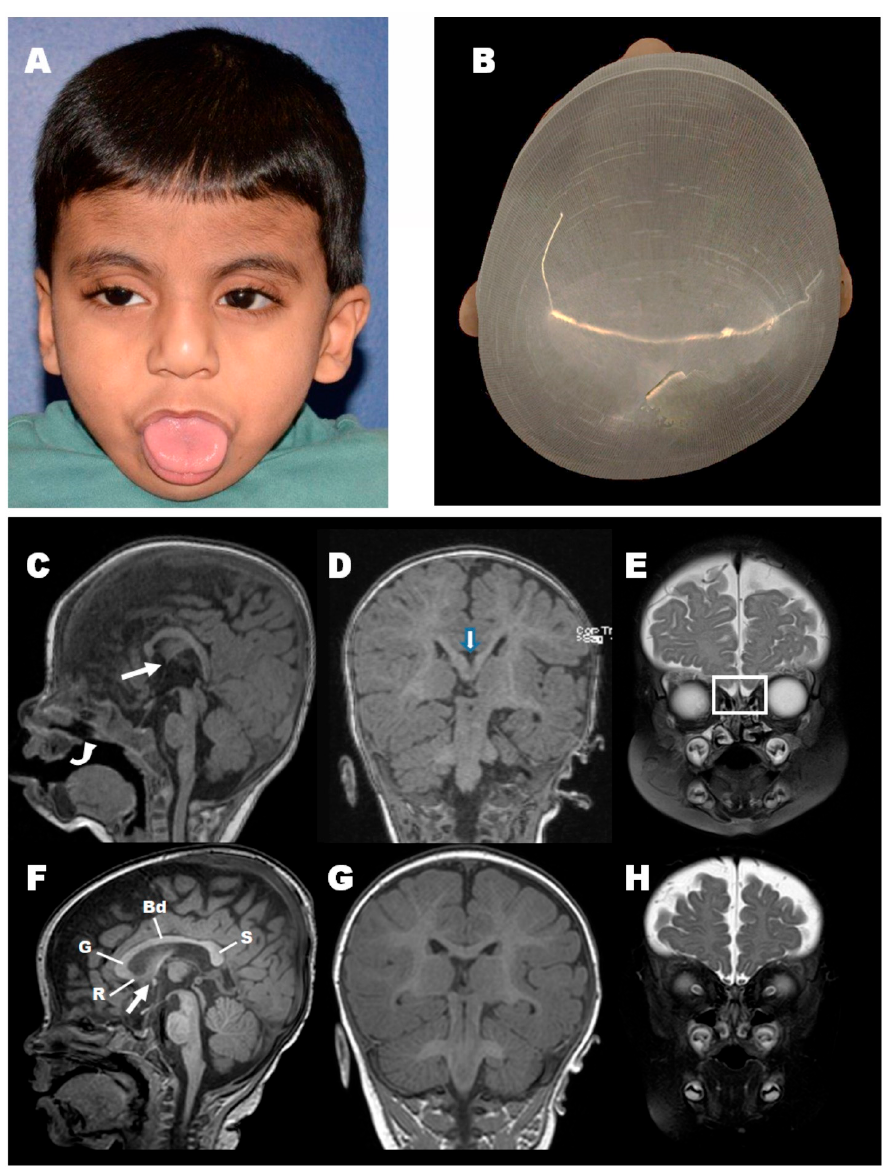
Figure 1. Reported case clinical presentation and Magnetic Resonance Imaging findings. Facial photos of the presented patient at 45 months of age. ( A ) Note the congenital blepharoptosis, tongue thrust posture, mild left ear constriction, mild frontal hirsutism. ( B ) Plagiocephalic head shape. (Note: The key clinical finding of cleft palate is not visible in these images). ( C ) Brain MRI showing midline sagittal T1 weighted image demonstrates a dysplastic corpus callosum with an atypical configuration showing focal thinning at the genu of the corpus callosum and an elongated vertically oriented splenium of the corpus callosum. The anterior commissure is hypoplastic (thin arrow). Cleft Palate is also noted (curved arrow). ( D ) Coronal T1 weighted image shows a cleft at the level of the splenium (thick arrow) denoting partial agenesis. ( E ) Coronal T2 weighted image shows the absence of the olfactory bulbs (Rectangle). ( F – H ) Similar views of an age match control show the normal configuration of the corpus callosum, which is divided into four parts: Rostum (R), genu (G), Body (Bd), and Splenium (S) as well as the anterior commissure (thin arrow). Note the olfactory bulbs on the coronal T2 weighted image ( F